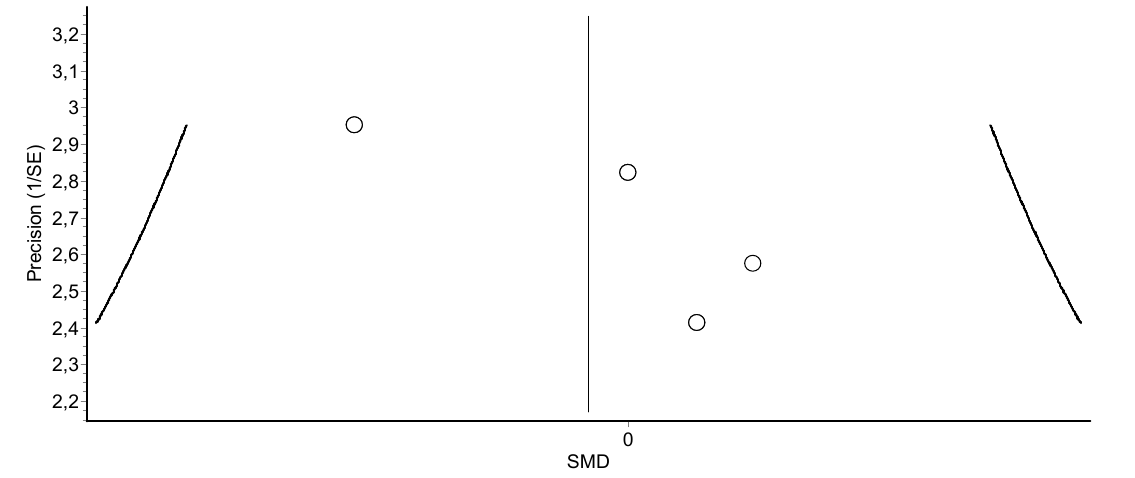
Figure A4. Synthesis funnel and Doi plot (LFK index) for resting systolic blood pressure.